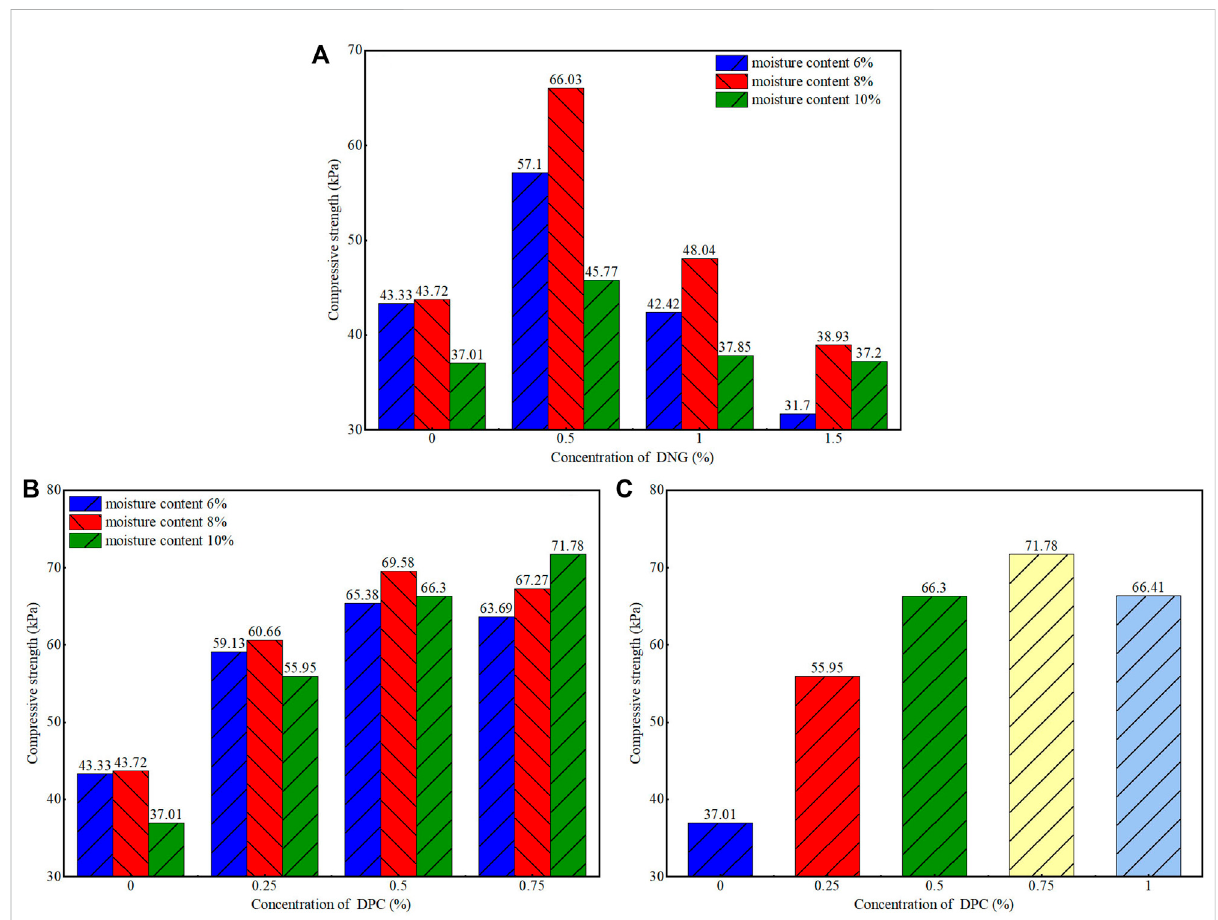
FIGURE 7 UCSTresultsofmixedsamplesofPPEandsiltysand.Differentmoisturecontent,differentconcentrationof (A) DNG,andsiltysand; (B) DPCand silty sand; (C) UCST of DPC and silty sand when the moisture content is